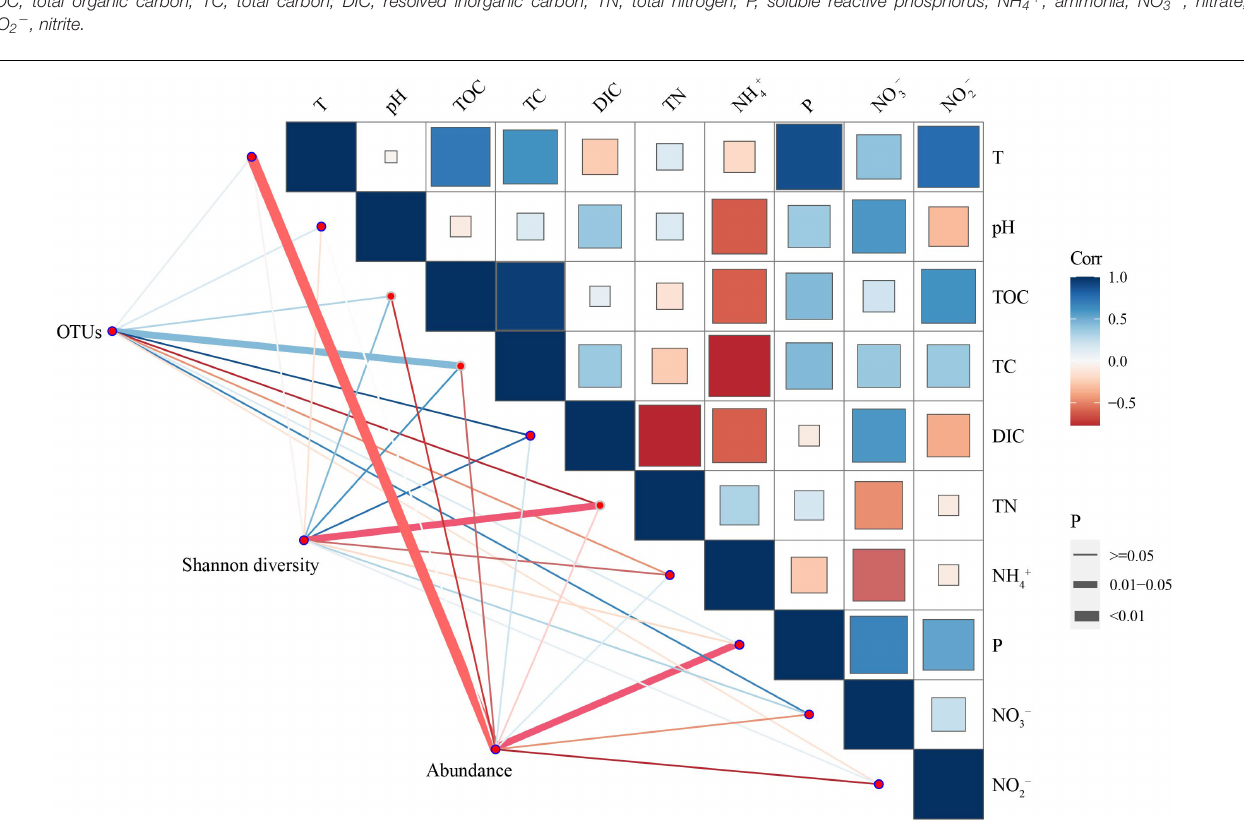
FIGURE 5 | Spearman’s correlation analysis based on the 16S rRNA gene of anammox bacterial diversity, abundance, and physicochemical parameters (including T, pH, TOC, TC, DIC, TN, NH 4 + , P, NO 2 − , and NO 3 − ) in six hot spring samples. The color scale denotes the nature of the correlation, with blue and red denoting the positive and negative correlations, respectively. The line thickness denotes different p -values; the thicker the line, the more significant correlation. On the contrary, the thinner the line, the less significant the correlation. T, temperature; TOC, total organic carbon; TC, total carbon; DIC, dissolved inorganic carbon; TN, total nitrogen; P, soluble reactive phosphorus; NH 4 + , ammonia; NO 3 − , nitrate; NO 2 − ,